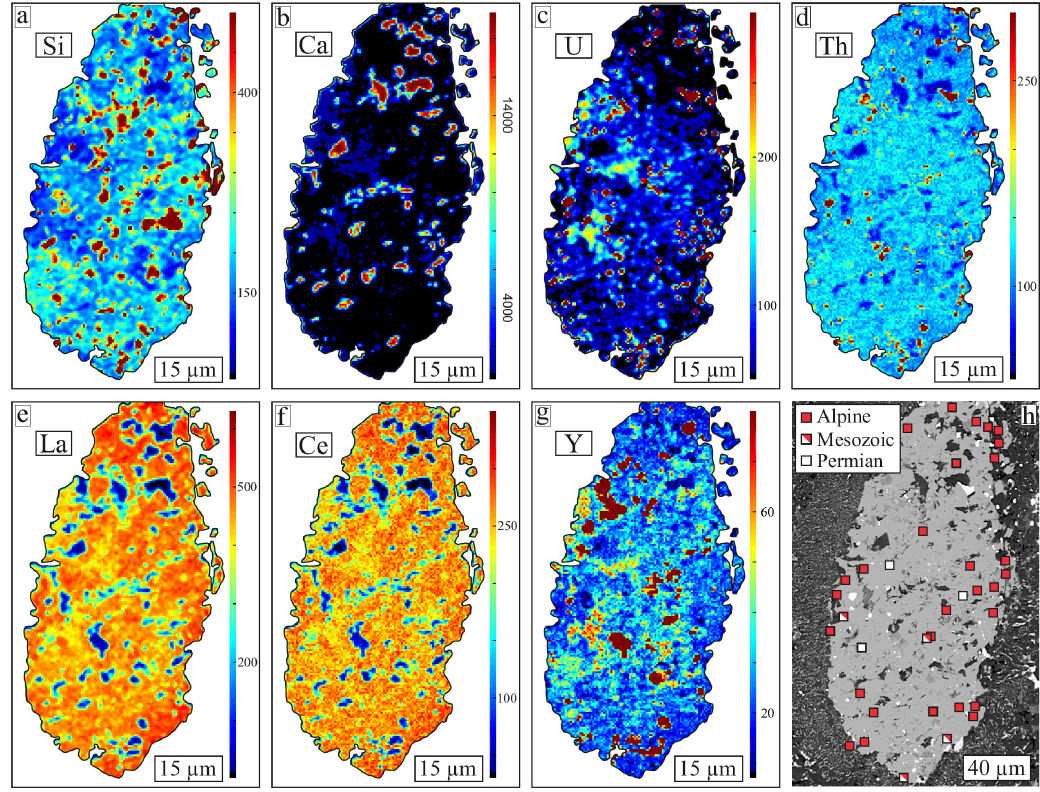
Figure 5. (a–g) Semi-quantitative element distribution maps for the monazite core from sample FH27 (unit: counts; compare Fig. 2f). (h) BSE image showing measurement points for EMP dating. Table 3. Representative fluorapatite analyses (left: wt.%; right: apfu) obtained by EMP (n.d.: not determined; b.d.l.: below detection limit).